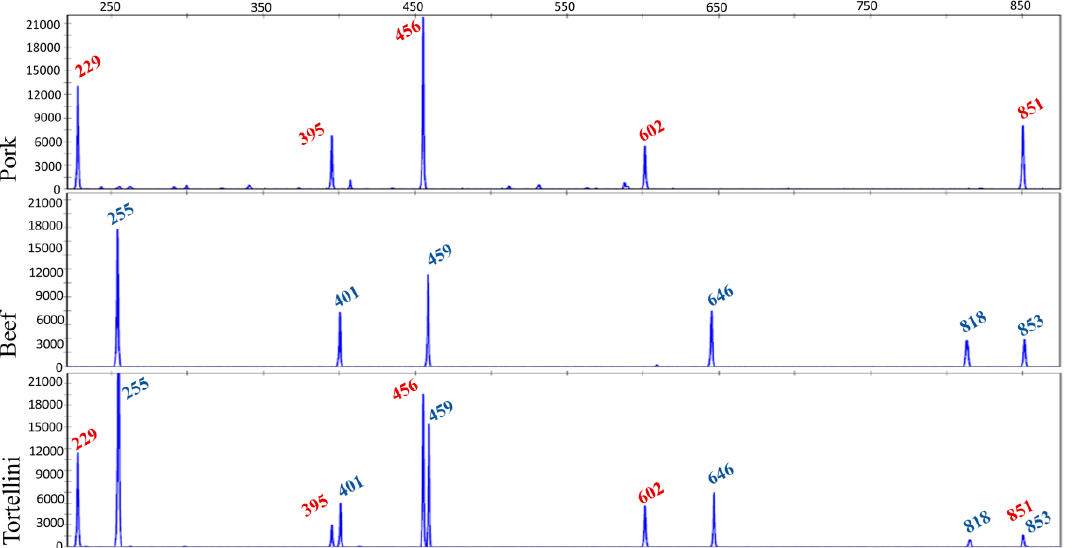
Figure 3. Meat-filling authentication in a sample of tortellini bought in the market. The TBP profile found in tortellini is compared with the pork and beef reference profiles. Numbers in the electropherograms refer to the length of the TBP-amplified fragment (peak size).